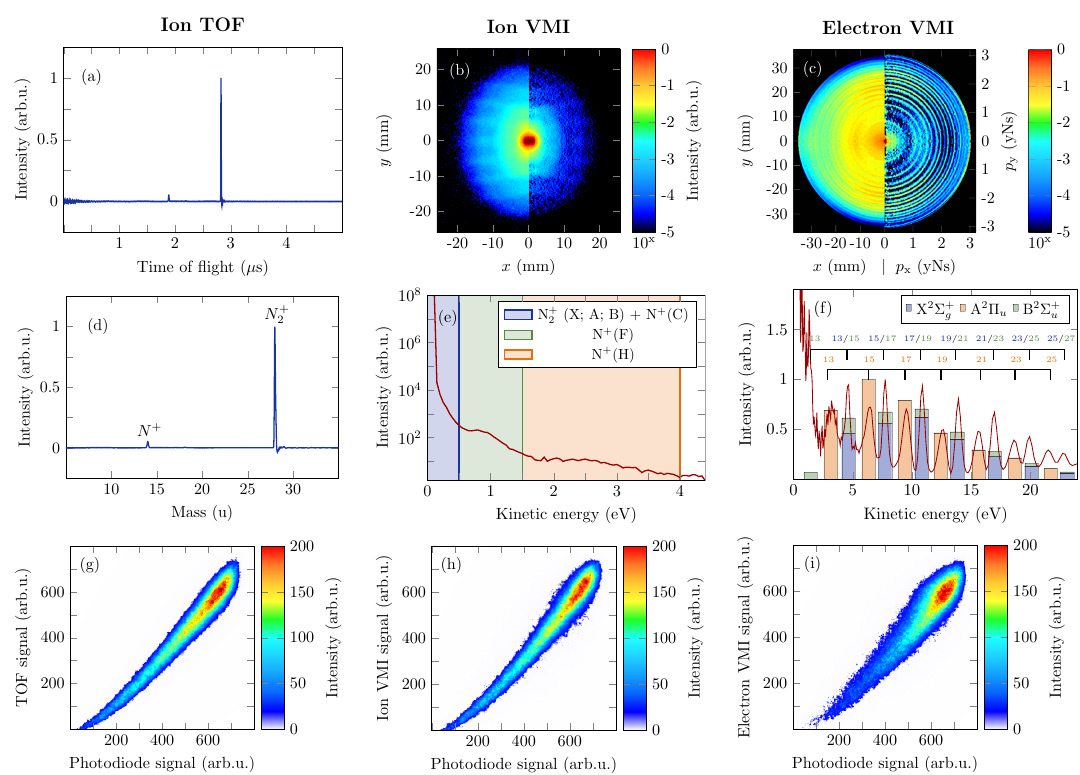
Figure 6. Experimental results in the high resolution electron mode 2(b) using high-order harmonics generated in argon to ionize N 2 . ( a , d , g ) show ion TOF data ( a ), with the calibrated mass spectrum in ( d ) and the correlation between the total ion TOF signal and the XUV intensity measured by the XUV photodiode visualized by a color-coded scatter plot in ( g ); ( b , e , h ) show ion VMI data, with the average detector image (left part) and inverted image (right part) in ( b ). The inverted images represent the reconstructed initial 3D momentum distributions obtained by inversion of the 2D projections recorded on the detector [23]. The photoion kinetic energy spectrum is displayed in ( e ) with its attributed contributions shaded in different colors, calculated from the inverted image ( b ). The correlation between the total ion VMI signal and the XUV intensity is exhibited in ( h ); ( c , f , i ) show electron VMI data, with the average detector image (left part) and inverted image (right part) in ( c ). The photoelectron kinetic energy spectrum is displayed in panel ( f ) with the attributed electronic molecular channels and the color-coded corresponding harmonic orders. The correlation between the total electron VMI signal and the XUV intensity is shown in ( i ). The slight bend observed for low intensities in the correlation plots is likely caused by a non-linear behavior of the photodiode in this signal